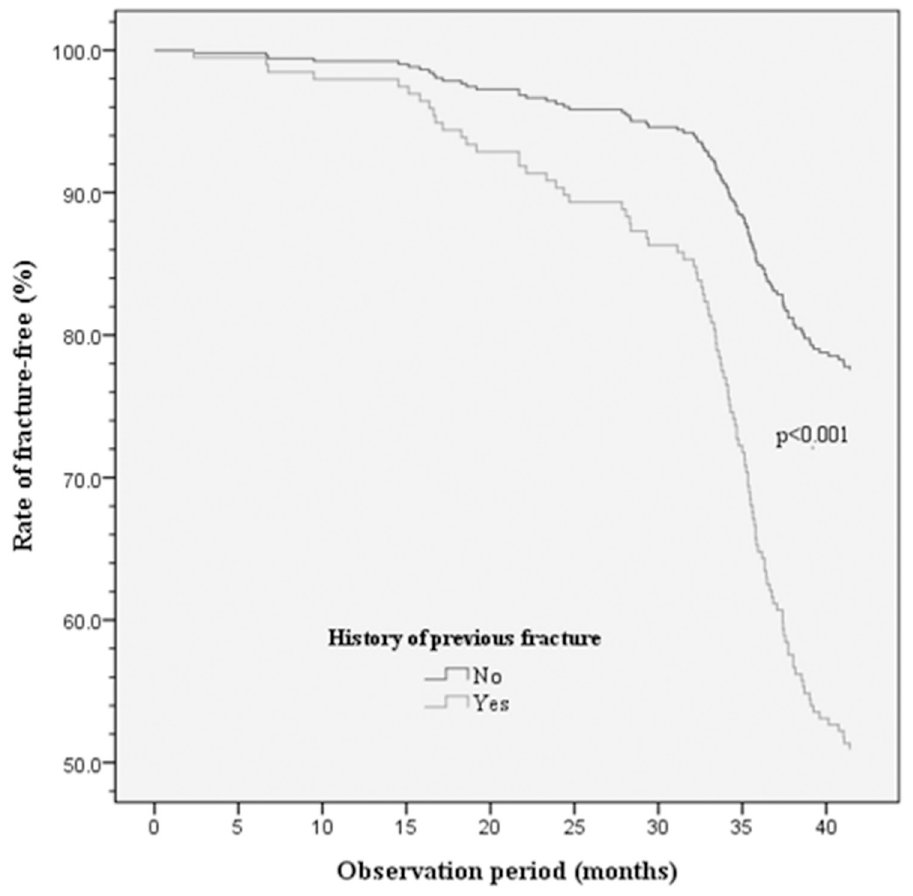
Fig 2. Impact of the history of a previous fracture on new